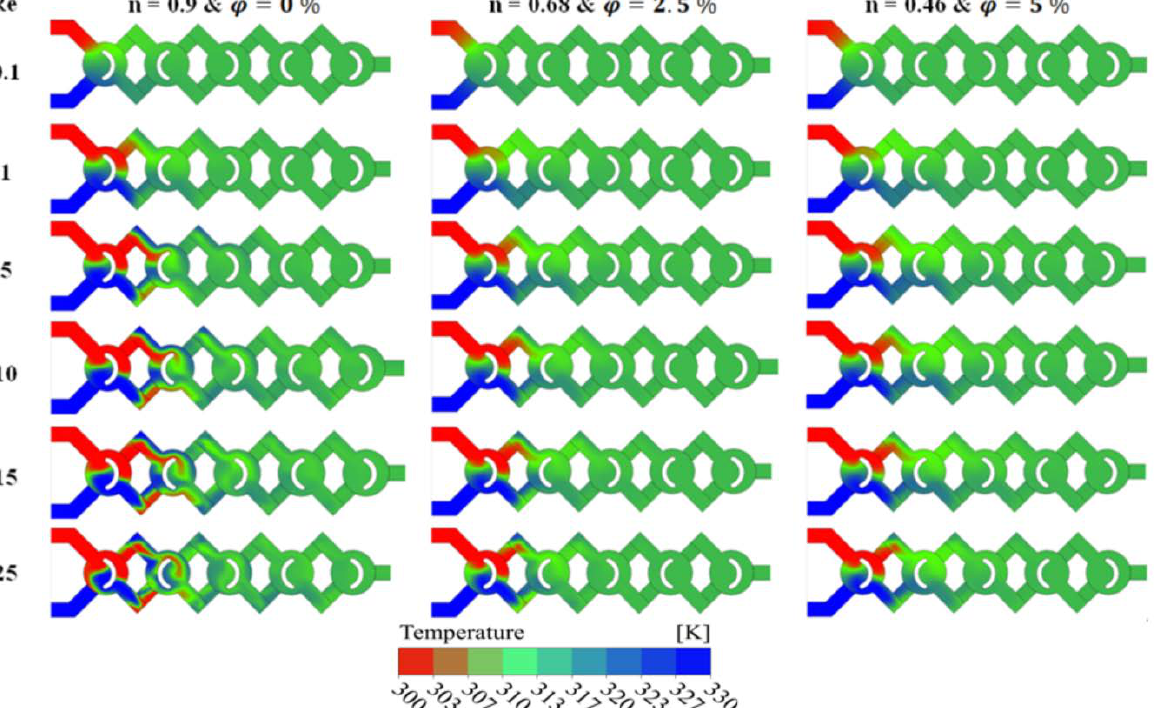
Figure 11. Qualitative representation of Temperature contours for different generalized Reynolds number at the horizontal middle section of each nano-fluid concentrations ( φ = 0.5 to 5%).